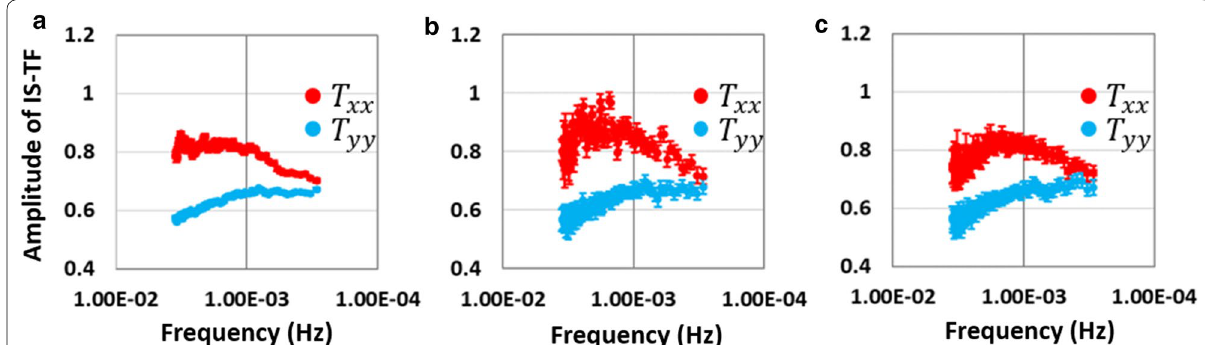
Fig. 6 Amplitudes of IS‑TFs of MMB (input) to KAK (output). a Standard IS‑TFs based on 22 months of data. b 2‑month IS‑TFs. c Two‑month IS‑TFs derived by removing time windows including anomalous geomagnetic events. Error bars correspond to 95% confidence